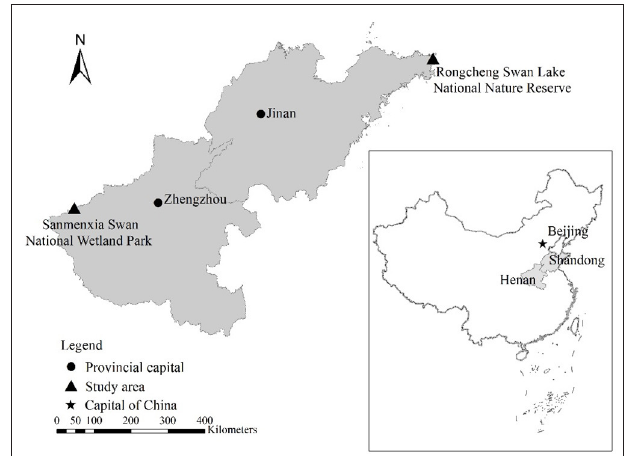
FIGURE 1 | Geographical location of whopper swan’s study